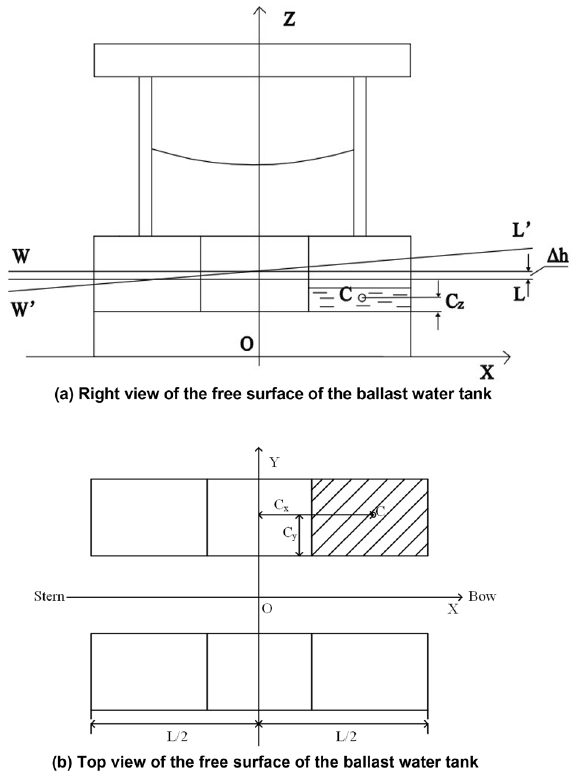
Figure 5. Robotic ballast tank under a free